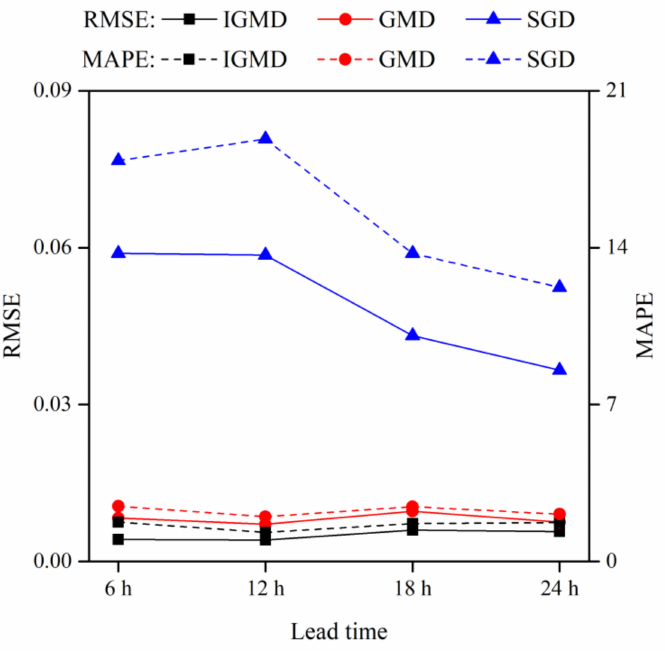
Figure 6. The RMSE and MAPE values that were used to evaluate the discrepancies between the fitted theoretical cumulative distribution models of the IGMD, GMD, and SGD models and the empirical cumulative